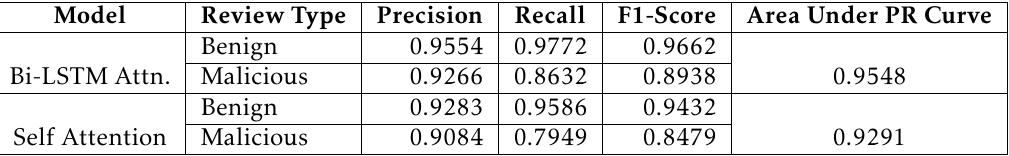
Table 7. Deep learning models’ accuracy with high quality